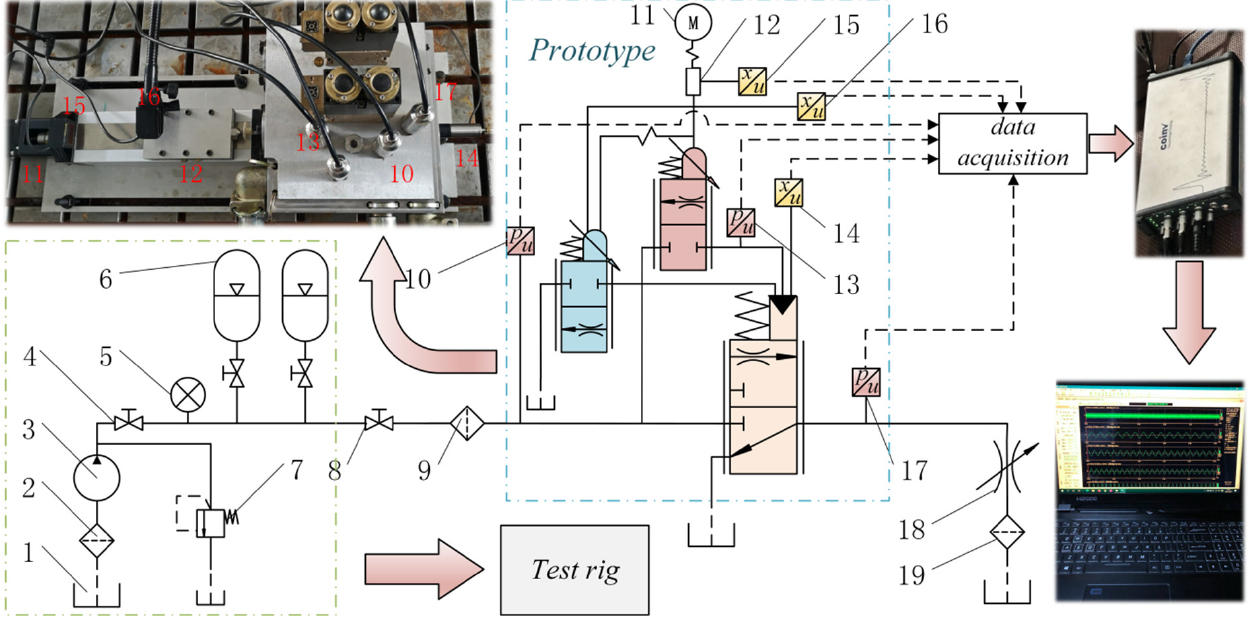
Figure 4. Principle of the hydraulic test system.